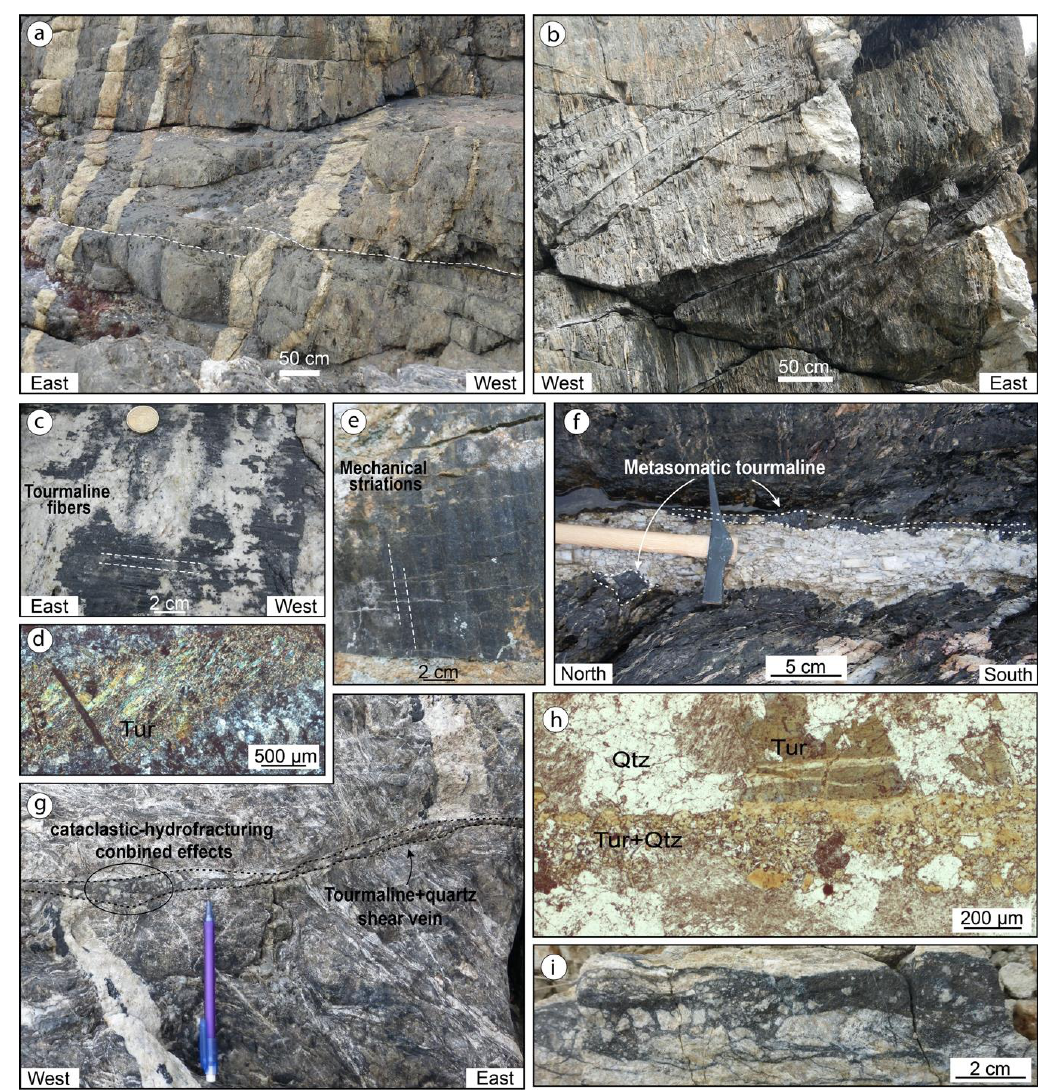
Figure 8. Faults and hydrothermal tourmaline shear veins in the Paleozoic micaschist. ( a ) Low-angle normal fault affecting Late Miocene leucogranite dykes; ( b ) fault slip-planes are characterized by tourmaline shear veins, crosscutting the leucogranite dykes; ( c) –( e ) tourmaline slickenlines on fault slip plane, with oblique- or normal slip movement; the thin section shows the dominant cataclastic texture of tourmaline, indicating syn-tectonic mineralization; ( f ) tourmaline-bearing metasomatic halos bounding a leucogranite dyke intruding the micaschist; ( g ) shear vein with tourmaline and quartz clasts deriving from cataclastic and hydrofracturing effects; ( h ) micrograph (plane polarized light) of neoformational tourmaline characterized by pale blue zonation due to the different composition (from schorl to dravite), and shear vein made up of cataclastic tourmaline; ( i ) detail of hydraulic breccia cemented by tourmaline and quartz; Mineral abbreviation from Reference [70].